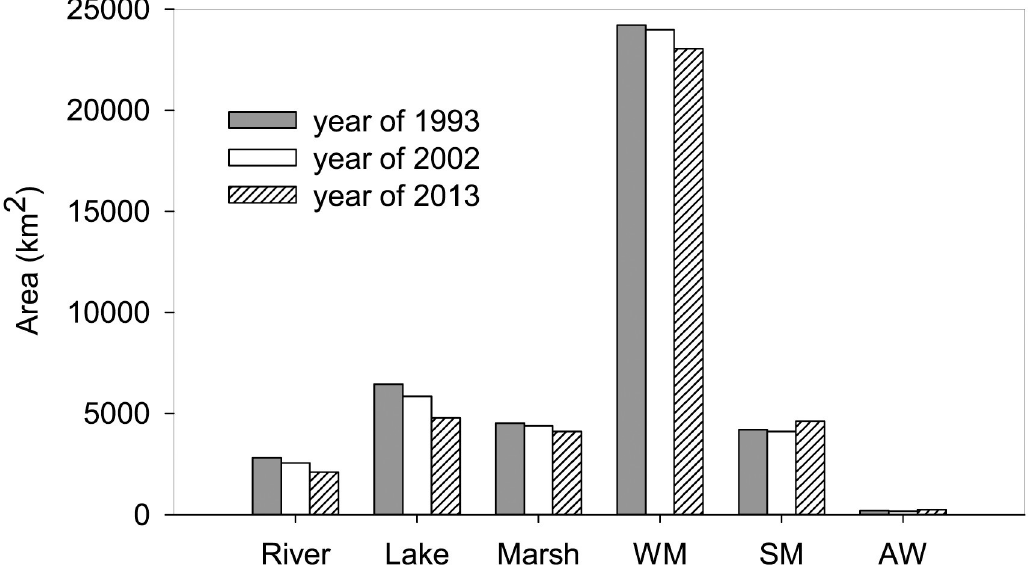
Fig 2. Dynamic change of wetland in IMAR. The abbreviation of wetland types: wet meadow (WM), salt meadow, artificial wetland